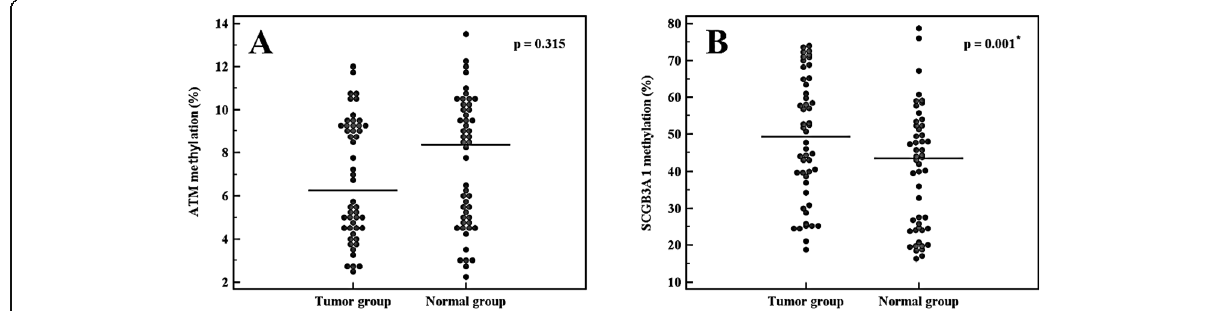
Fig. 3 Comparison of the methylation levels of ATM ( A ) and SCGB3A1 ( B ) genes in tumor samples and paired normal samples. Horizontal lines provided median methylation levels of each